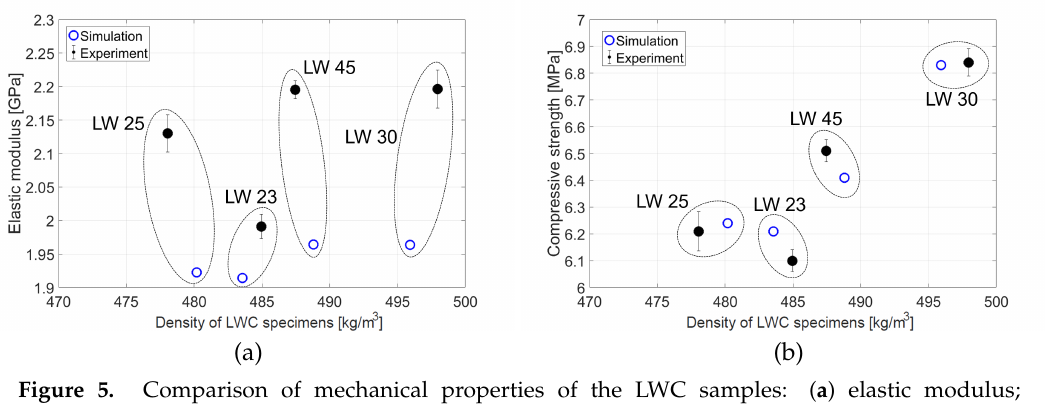
Figure 5. Comparison of mechanical properties of the LWC samples: ( a ) elastic modulus; ( b ) compressive